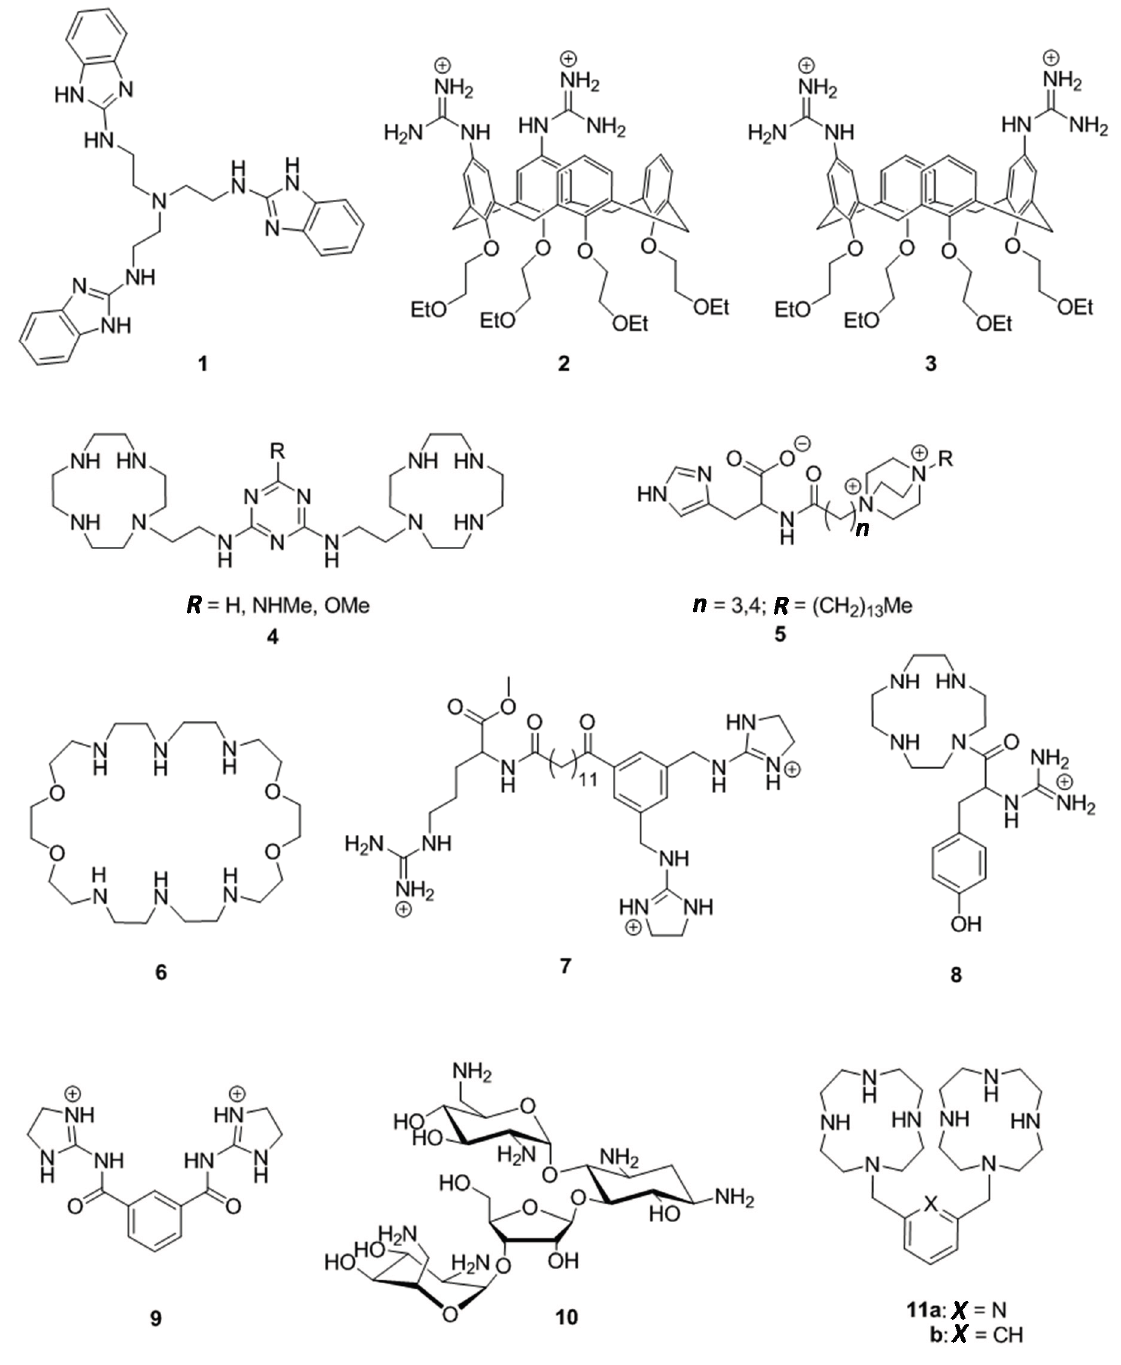
Figure 1. Representative examples of nonmetallic cleaving agents described in the